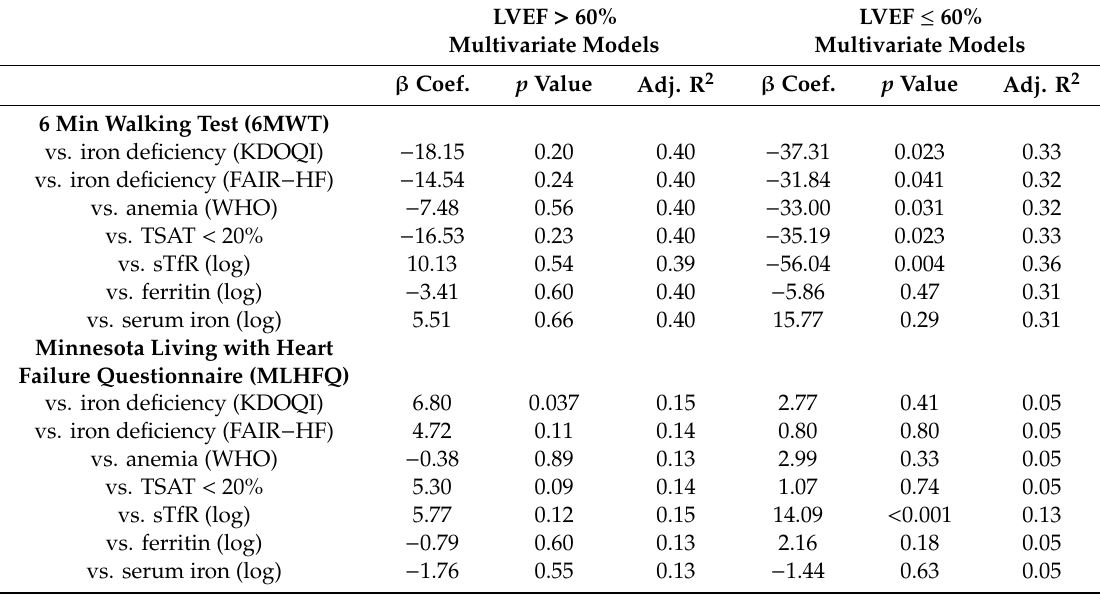
Table 4. Multivariate linear regression models for 6MWT and MLHFQ according to LVEF.